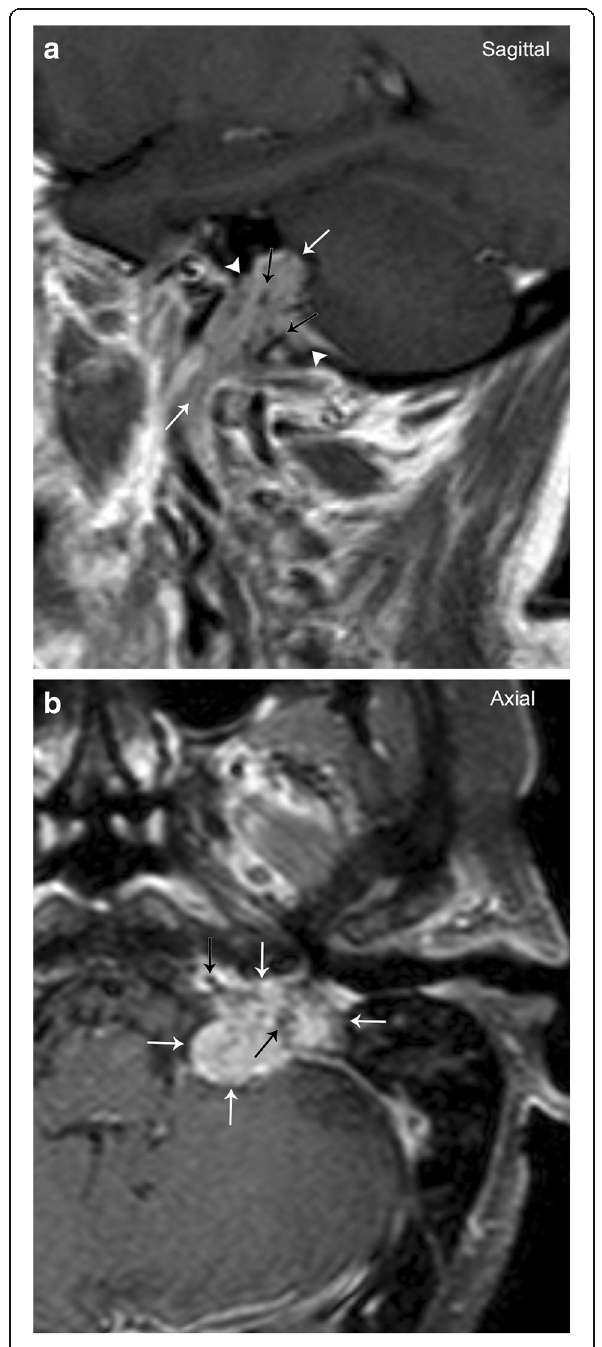
Fig. 3 Glomus Jugulare. Sagittal ( a ) and axial ( b ) T1 post-contrast images demonstrate an enhancing mass (white arrows) centered at the jugular foramen (arrowheads). Note the prominent flow voids (black arrows) typical of a glomus tumor